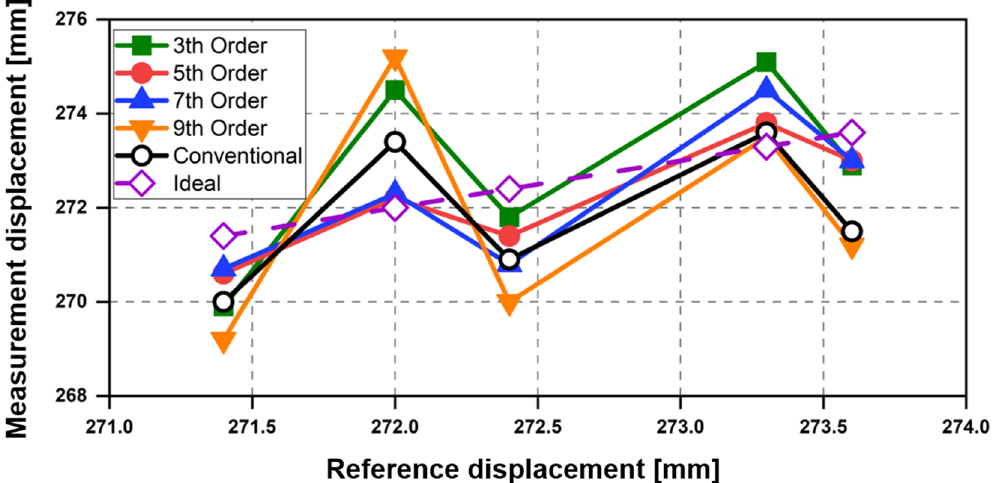
Figure 12. Measurement error in the displacement obtained by the CW radar depending on the DC offset cancellation method.